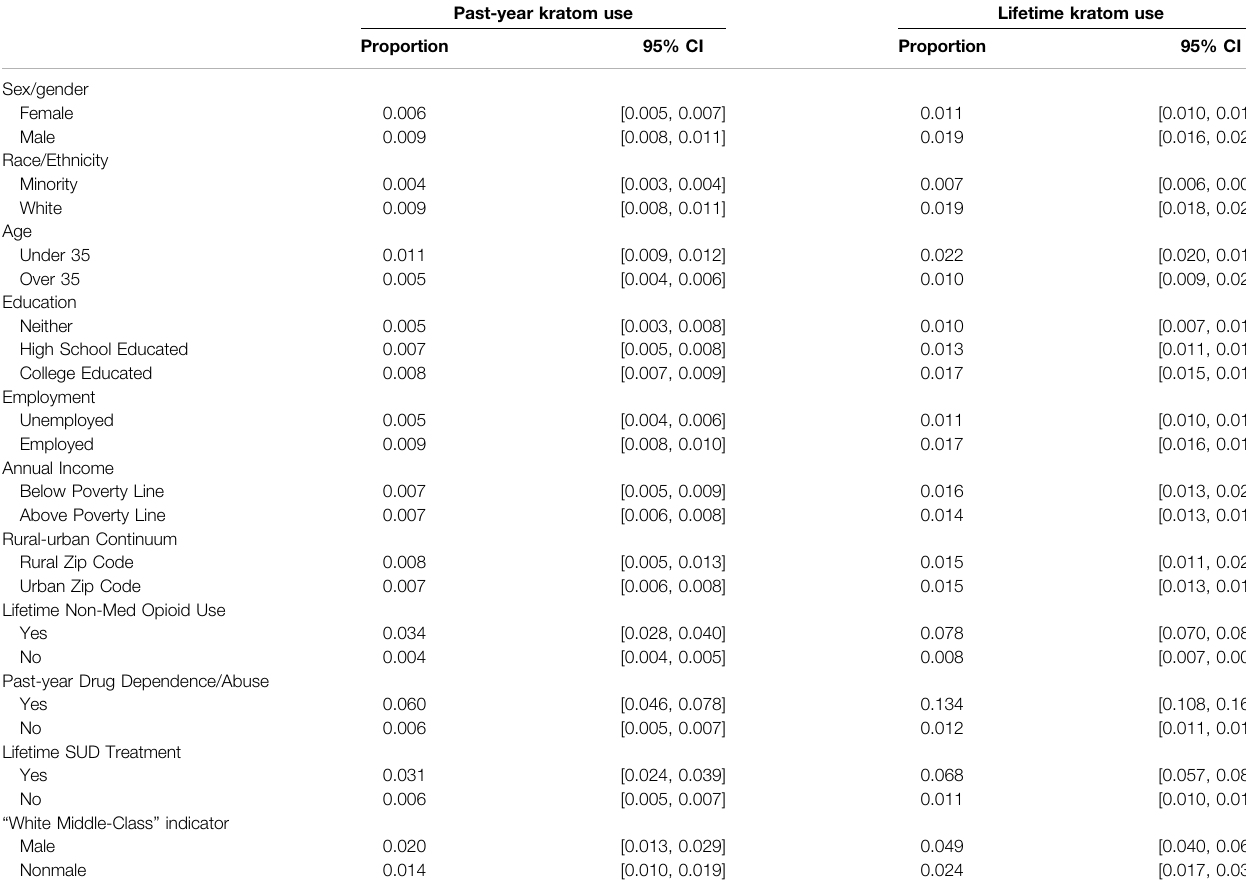
TABLE 2 | Survey-weighted proportions of respondents with lifetime and past-year kratom use, National Survey on Drug Use and Health (NSDUH), 2019. Past-year kratom